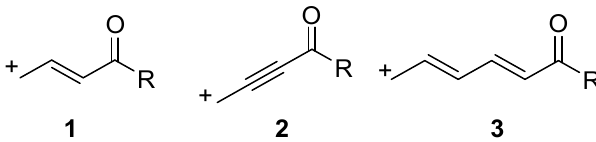
γ - and ε -carbonyl Figure 1. γ- and ε- carbonyl cations. Figure 1.